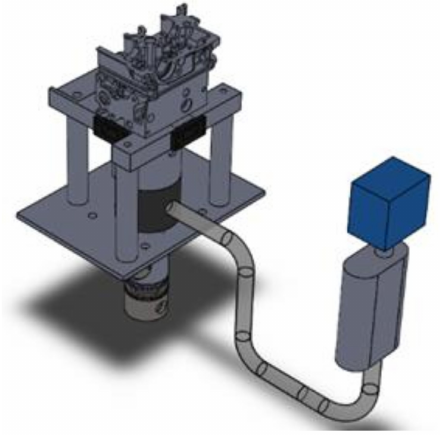
Figure 6. Setup of blow-by